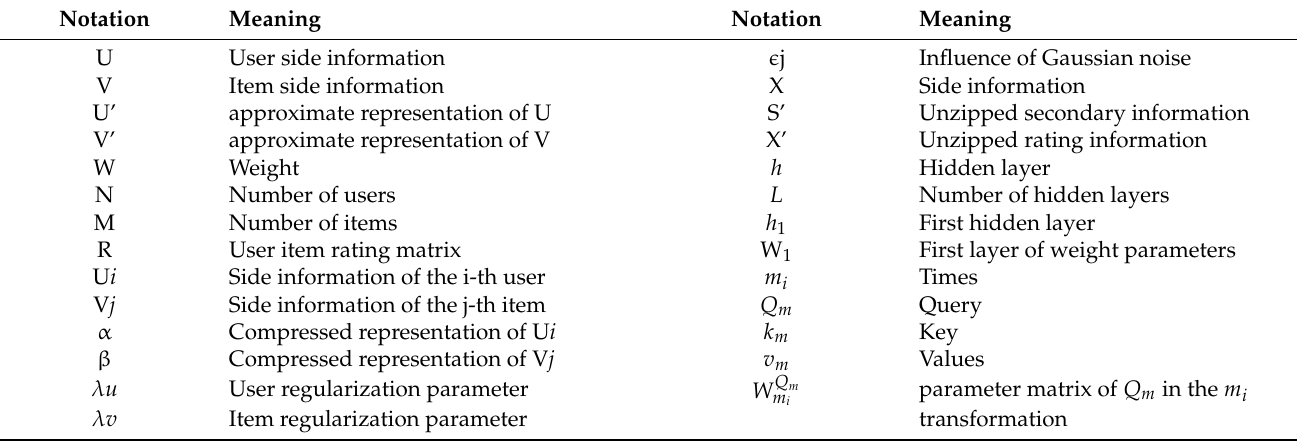
Table 1. Summary of symbols